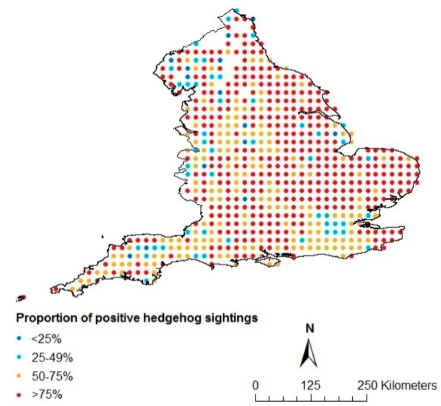
Figure 1. Proportion of positive hedgehog sightings according to the ‘HogWatch’ survey of 2005–2006.